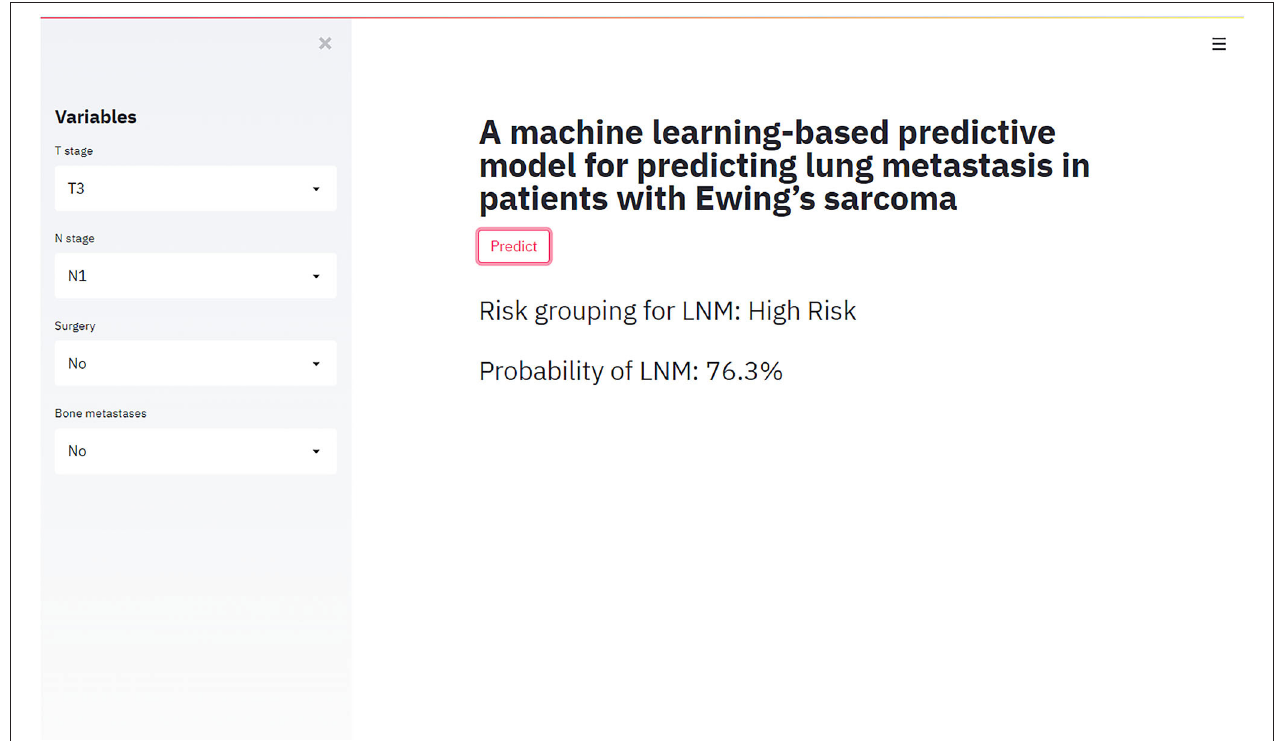
FIGURE 5 | The web-based tool designed for predicting lung metastasis in patients with Ewing